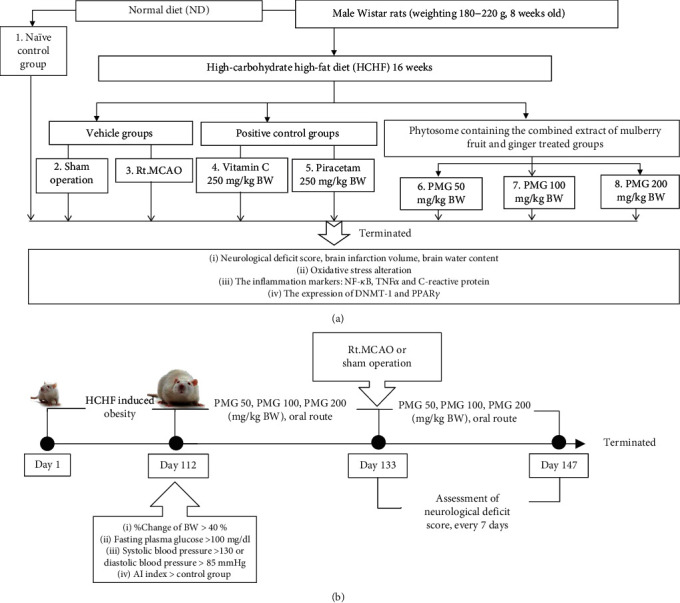
Schematic diagram showing all experimental procedures. (a) Experimental protocol of PMG treatment and the determination of various parameters. (b) Rt. MCAO induction and schedule for PMG treatment. Rt. MCAO: right middle cerebral artery occlusion; NF-κB: nuclear factor-kappa-B; TNFα: tumor necrosis factor-alpha; DNMT-1: DNA methyltransferase-1; PPARγ: peroxisome proliferator-activated receptor gamma; PMG 50, PMG 100, and PMG 200: the phytosome containing the combined extract of mulberry fruit and ginger at doses of 50, 100, and 200 mg.kg−1 BW, respectively.